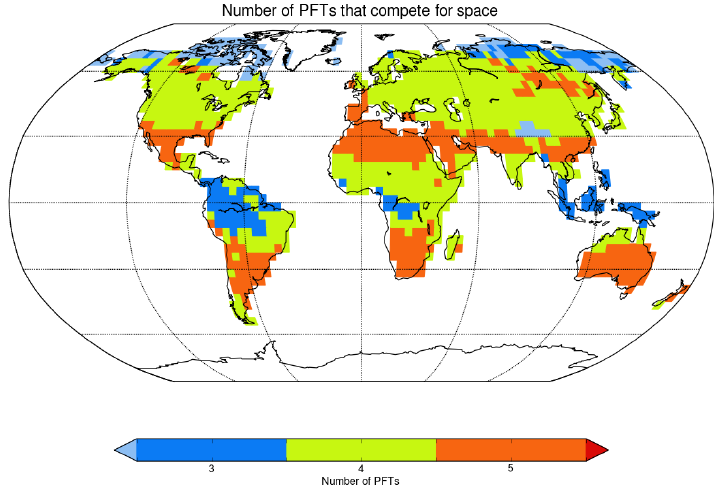
Figure 9. Plot showing the maximum number of PFTs in the pre-industrial equilibrium CTCOMP and LVCOMP simulations that can compete for space within a grid cell based upon each PFT’s bioclimatic limits. The total number of natural non-crop PFTs represented in CTEM is